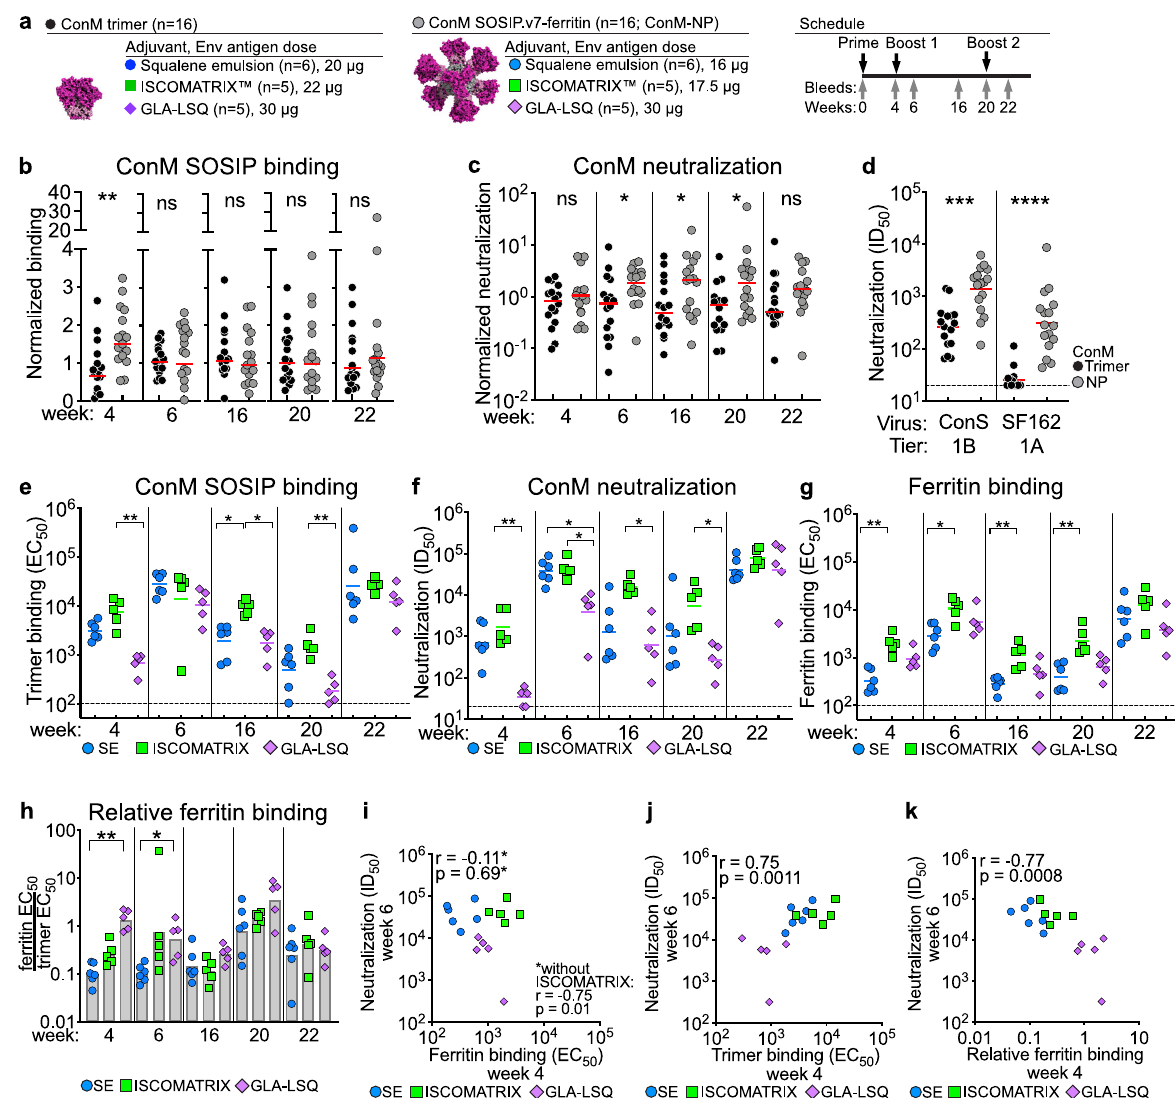
Fig. 2 Immunogenicity of adjuvanted ConM SOSIP.v7-ferritin in rabbits. a Rabbit immunization groups and schedule. The three ConM SOSIP.v7-ferritin nanoparticle (ConM-NP) groups with ISCOMATRIX, SE, and GLA-LSQ are compared to trimers in the same three adjuvants. b ConM SOSIP.v7 binding titer comparison from ELISA. Serum-binding EC 50 titers of rabbits were normalized for each adjuvant to allow a comparison between the trimer and ferritin group. The normalized EC 50 titers of the sixteen ConM trimer or ConM-NP immunized rabbits were compared at every time point. c Neutralization titers against ConM virus by nanoparticle or trimer immunized rabbits. The neutralization titers (ID 50 ) of rabbits were fi rst normalized for each adjuvant to allow a comparison between the trimer and nanoparticle group. d Neutralization titers (ID 50 ) from week 22 against ConS or SF162 virus induced by trimers or nanoparticles in rabbits. Data were published before in 11,56 , see also Supplementary Table 2. e Binding titer comparison of the different adjuvanted ConM-NP groups. f Neutralization titers of sera from rabbits that received ConM-NPs with either SE, ISCOMATRIX, or GLA-LSQ. g Midpoint binding titers against the ferritin cage by ConM-NP immunized rabbits. Data are represented as geomeans + geomean SD from fi ve or six biological replicates. Stars denote signi fi cant differences between the ISCOMATRIX and SE groups by Kruskal – Wallis test, Dunn ’ s post-test. h Relative ferritin binding by ConM-NP immunized rabbits. Ratios are derived from the midpoint binding titers of Figs. 2E and 2G. i Simple linear regression analysis of ferritin binding at week 4 ( g ) and ConM neutralization at week 6 ( f ). j Simple linear regression analysis of SOSIP binding at week 4 ( e ) and ConM neutralization at week 6 ( f ). k Simple linear regression analysis of relative ferritin binding at week 4 ( h ) and ConM neutralization atweek 6 ( f ). Spearman r and p value are indicated. Stars denote statistical differences: * p < 0.05; ** p < 0.01; *** p < 0.001. See also Supplementary Table 2. All data were generated at the AMC. Horizontal lines represent geometric mean